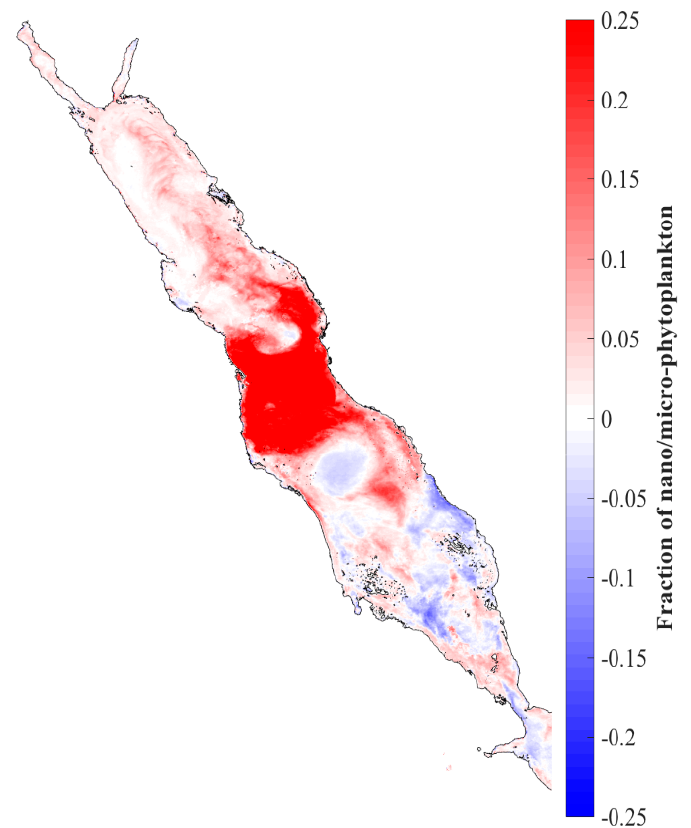
Figure 5. Monthly anomaly of the fractional contribution of nano/micro-phytoplankton ( F n,m ) to total Chl-a concentration in October 2002. Positive (negative) values shown in red (blue) represent higher (lower) fractions of nano/micro-phytoplankton in comparison to the climatological average computed for the period 1998–2018.